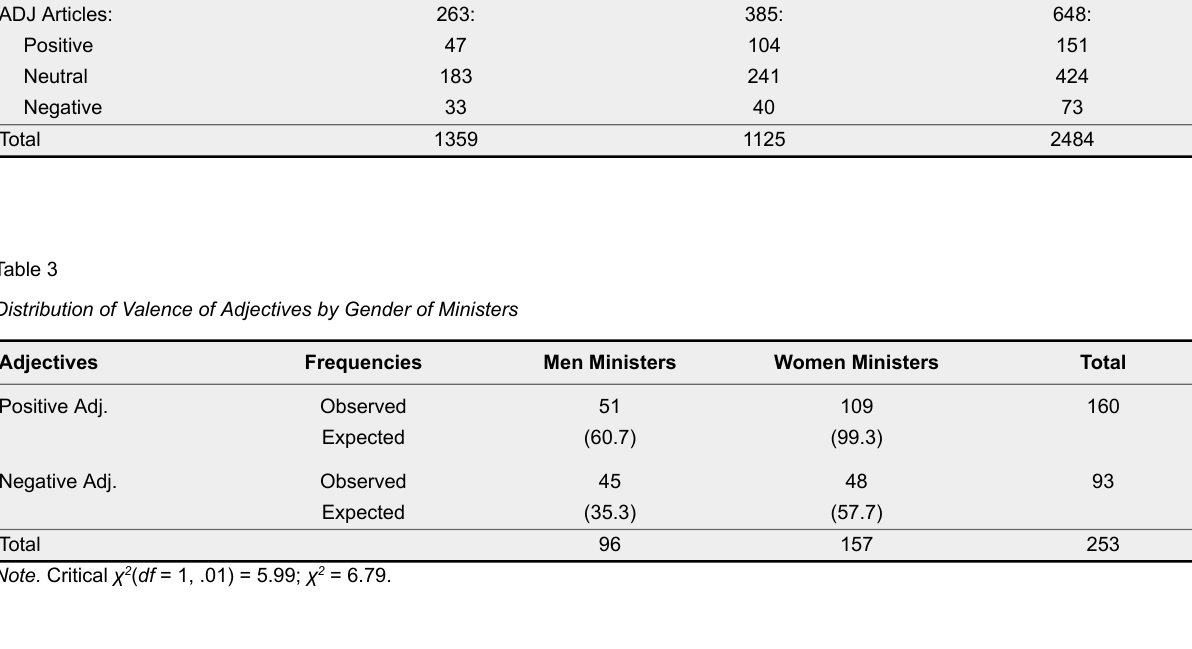
TotalWomen MinistersMen